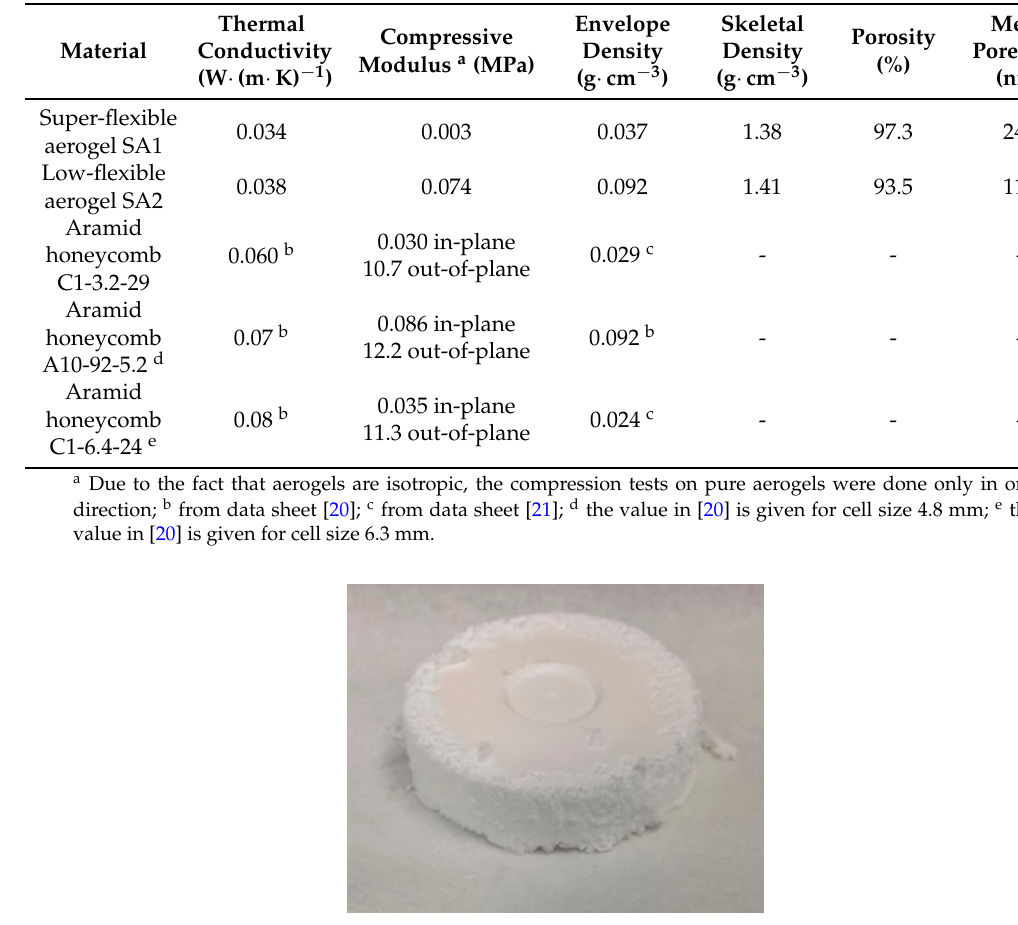
Figure 1. Super-flexible silica aerogel SA1.